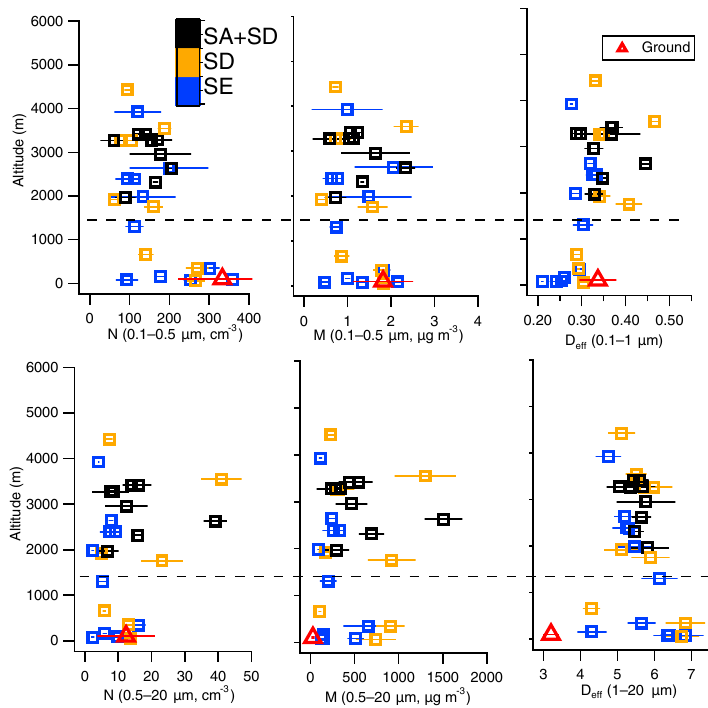
Figure 12. The particle mass and number concentrations as a function of altitude for particles in the size range d (0.1–0.5)µm and d (0.5– 20)µm, and effective diameters in the size range (0.1–1) and (1–20)µm obtained from the PCASP and CDP measurements for all SLRs. The markers are colour coded according to the BT classification and show the mean value together with bars indicating a 1 σ variability for each SLR. The surface measurements from the scanning mobility particle sizer spectrometer (SMPS) and APS instruments are also shown (red triangles).